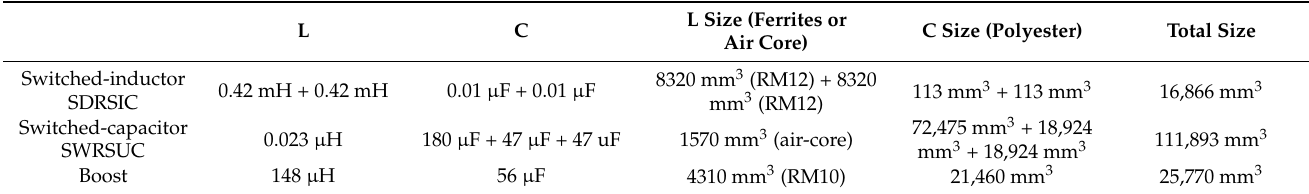
Table 1. Comparison of converter size and power density.